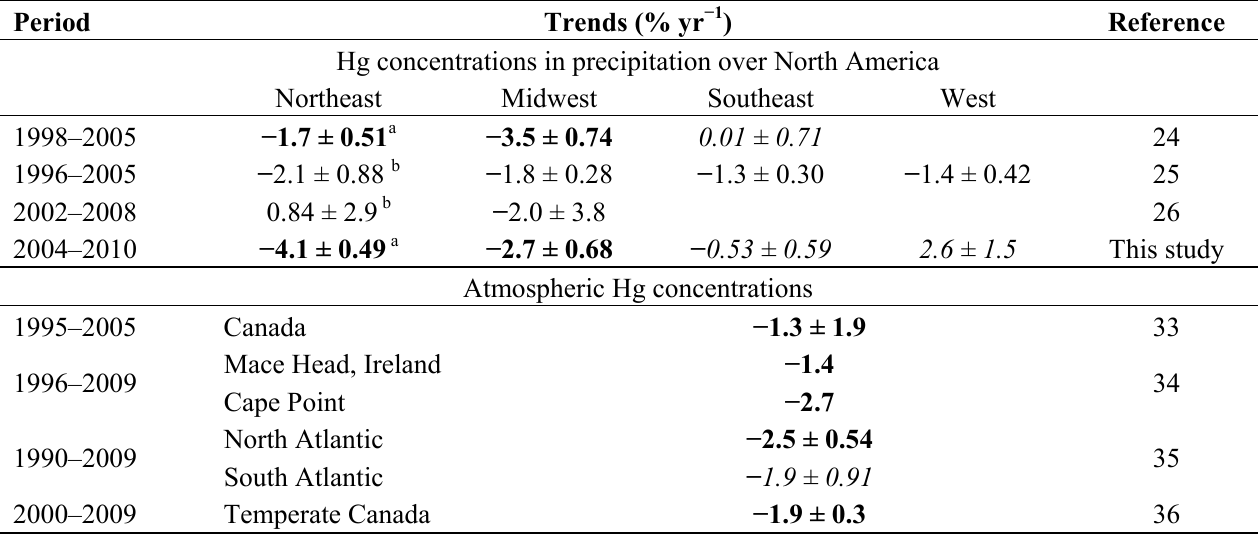
Table 1. Summary of trends in Hg concentrations in precipitation and atmospheric concentrations from selected studies in the